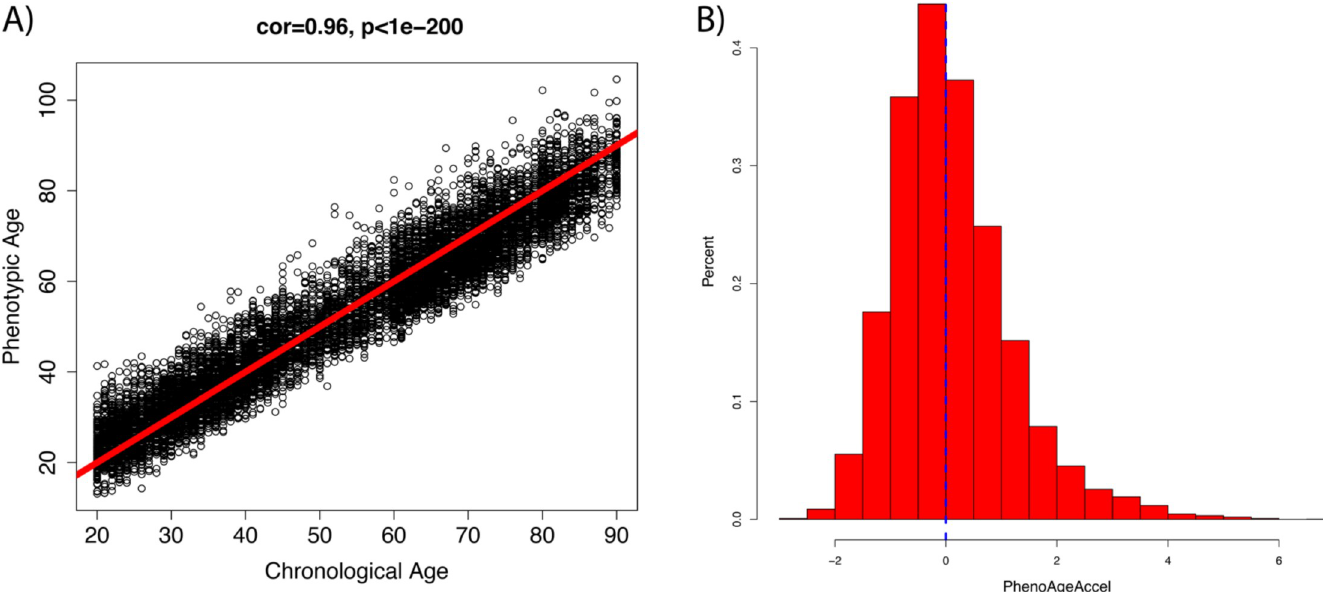
Fig 3. Relationship between Phenotypic Age, chronological age, and PhenoAgeAccel. (A) As expected, Phenotypic Age was highly correlated with chronological age, partially due to the fact that it includes chronological age. The red line depicts the expected Phenotypic Age for each chronological age, with points above the line depicting people who were phenotypically older than expected, and points below the line depicting those who were phenotypically younger than expected. (B) PhenoAgeAccel was fairly normally distributed, with a mean of 0 (blue line), a standard deviation of 1, and a median of − 0.13.